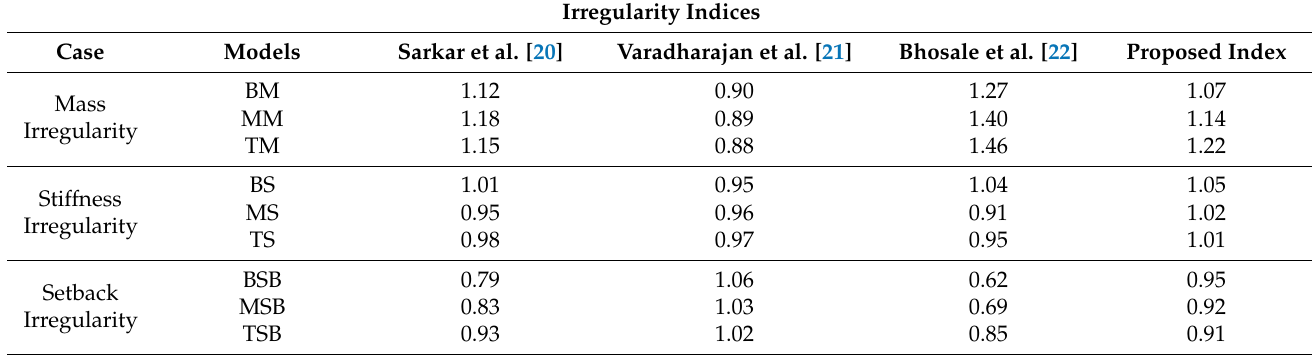
Table 5. Comparison of the previous indices and proposed index for studied